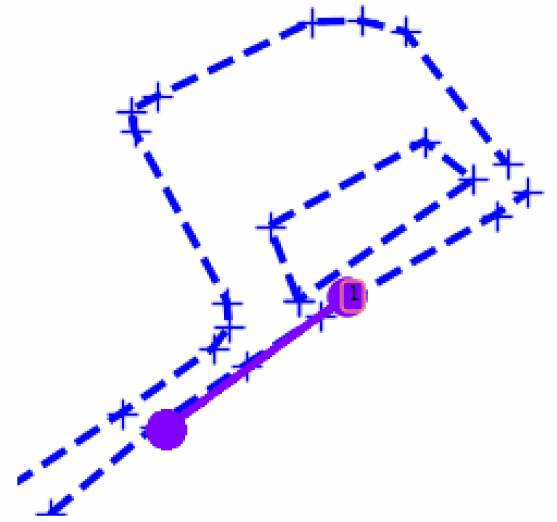
Figure 7. Tracking from fusion output. A person walks along the road; their presence is confirmed by the firing of PIR sensors and the thermal camera. The tracking system attributes an ordered tracking ID, ‘1’, for this tracked